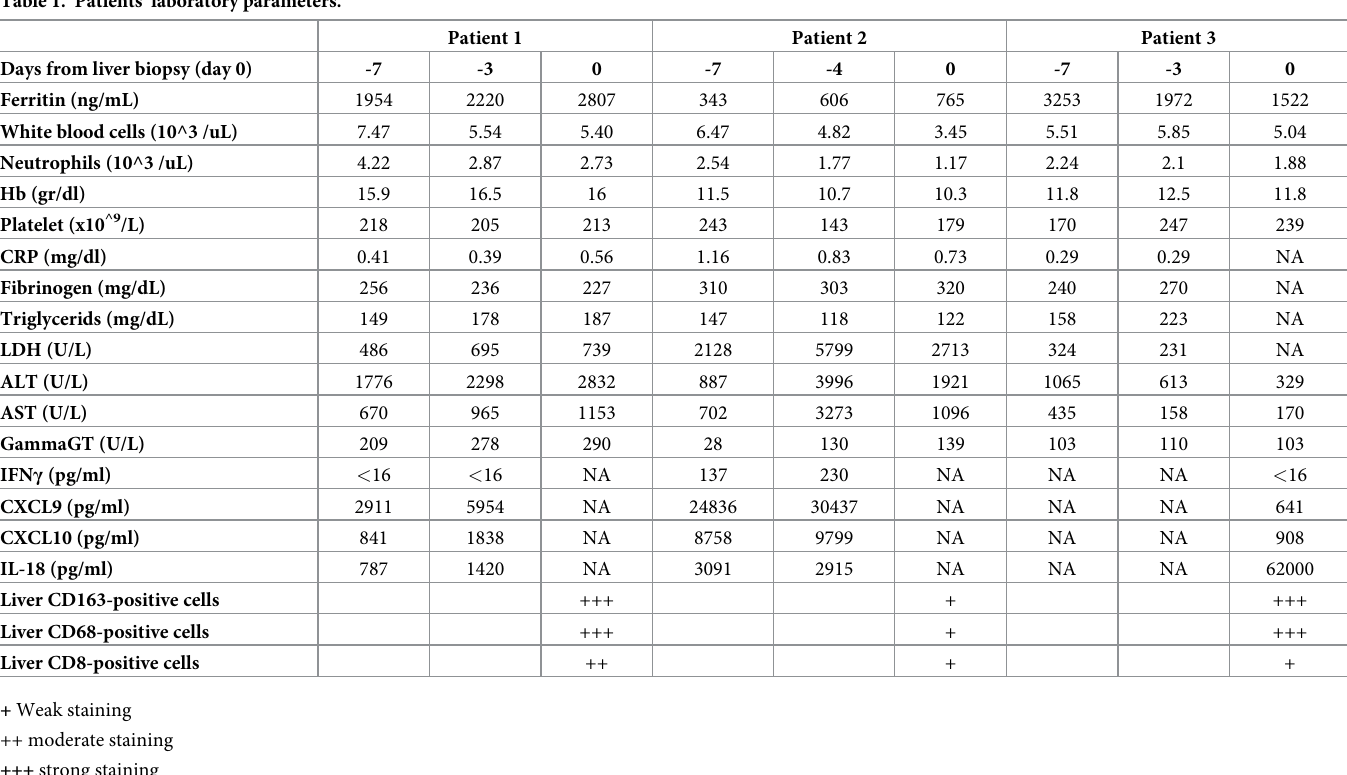
Table 1. Patients’ laboratory